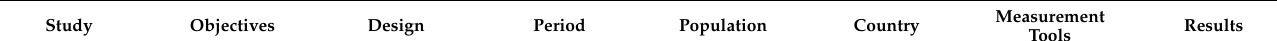
Table 4. Summary of the main data of the studies considered in this review—Individuals with